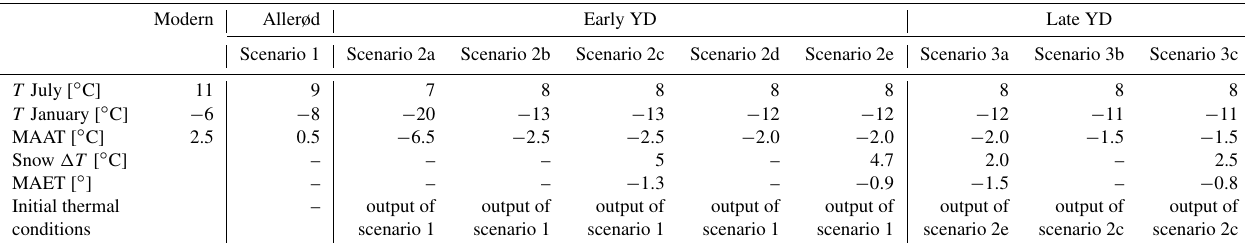
Table 1. Input parameters for 1D heat conduction models simulating climate during the Allerød interstadial (1), the early YD (2a–2e) and the late YD at the study site (3a–3c). Snow (cid:49)T describes the attenuation of the winter cold by the snowpack, whereas the resultant annual air temperature used as a boundary condition for the thermal model is expressed as the mean annual effective temperature (MAET). Modern-day values are shown for